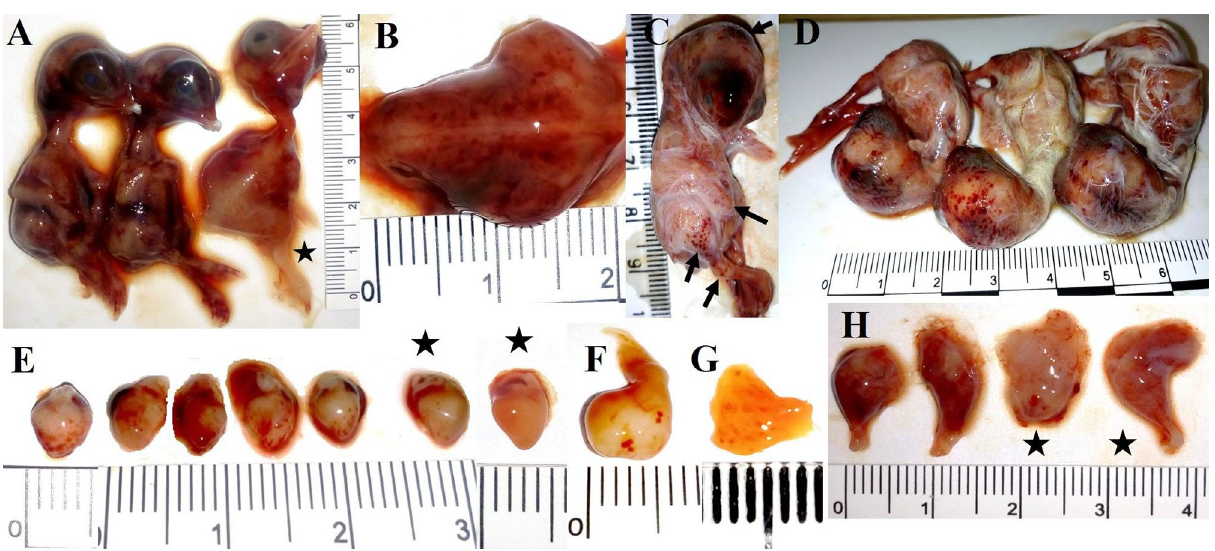
Figure 3. Pathomorphological lesions of SPF chicken embryos (1–4 dpi) inoculated with Enterococcus cecorum strains. (A) Comparison between congested embryos (2 dpi) infected with clinical E. cecorum and embryo infected with commensal (*) E. cecorum (approx. 3.4 × 10 6 cfu/egg) ( B) Hemorrhages of skeletal muscles in embryos infected with clinical E. cecorum. (C) Hemorrhages on the head and petechiae on the legs (4 dpi) (D) Petechiae on the skull of embryos infected with clinical E. cecorum . (E) Petechiae on the epicardium of embryos infected with clinical and commensal (*) E. cecorum isolates. (F) Petechiae on the gizzard (3 dpi) and (G) on the mucosa of proventriculus (7 dpi) of embryo infected with clinical E. cecorum . (H) Hemorrhages on thigh muscles in embryos (2 dpi) infected with clinical (CB, CL, respectively) and commensal (*) E. cecorum isolates (approx. 3.4 × 10 7 Pathomorphological Lesions. The most prominent macroscopic lesions occurred in embryos infected with the highest doses (approx. 3.4 × 10 7 cfu/egg, 3.4 × 10 6 cfu/egg) of clinical E. cecorum that died on 13 di (2 dpi). No lesions were observed in the embryos of the control group. Embryos that died until 15 di (4 dpi) inclusive after infection with chicken isolates (CB, BB, CL) showed severe macroscopic lesions: generalized body congestion, multifocal hemorrhages in the pectoral and thigh muscles, and petechial hemorrhages beneath the epicardium, in the gizzard wall, and in the proventriculus mucosa (Fig. 3). In addition, an abnormal yolk sac content (cloudy, dense, greenish) was noted. The liver was enlarged, friable, congested or greenish in color. The kidneys were congested, the spleen was enlarged, congested or pale, the bursa of Fabricius was enlarged. Embryos infected with commensal isolates showed no or less pronounced lesions. In addition, the surviving embryos (on 7 dpi, 18 di) showed no lesions, but single embryos (receiving the high dose) had abnormal spleen, liver, or yolk sac. Histopathological examination of the tissue samples of dead embryos showed aggregates of bacteria in blood vessels in the liver, kidney, heart, gizzard, and brain, multiple areas of necrosis in the liver and heart, and necrosis of renal tubular epithelial cells and gizzard smooth muscle cells. In addition, dead embryos showed encephaloma- lacia, hemorrhages in the liver, kidney, and heart, as well as marked congestion of the proventriculus, gizzard, and brain (Fig. 4). Tissue samples from the surviving embryos revealed inflammatory response (hepatitis, glomeru- lonephritis, pericarditis, and proventiculitis), glial and endothelial cell reaction in the brain, and mainly mild to